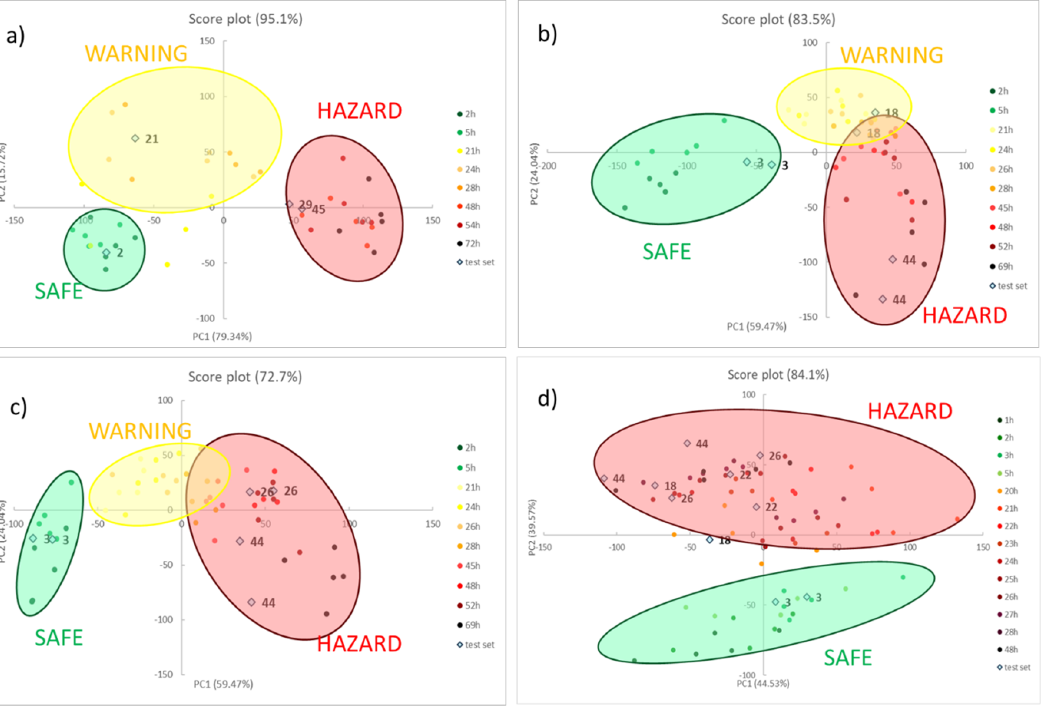
Figure 3. The score plots of the PCA models on the first two principal components, considering all the samples of chicken meat ( a ), beef meat ( b ), pork meat ( c ) and cod fillets ( d ) kept at room temperature. The ellipsoids are exclusively added as a simplification of the different groups: SAFE, WARNING and HAZARD.